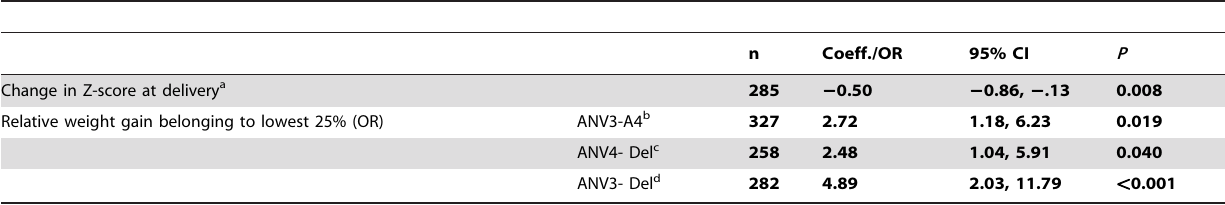
Table 5. The effect of malaria among primi- and secundigravidae on z-score of birth weight, relative weight gain from ANV3 to ANV4, ANV4 to delivery, and ANV3 to